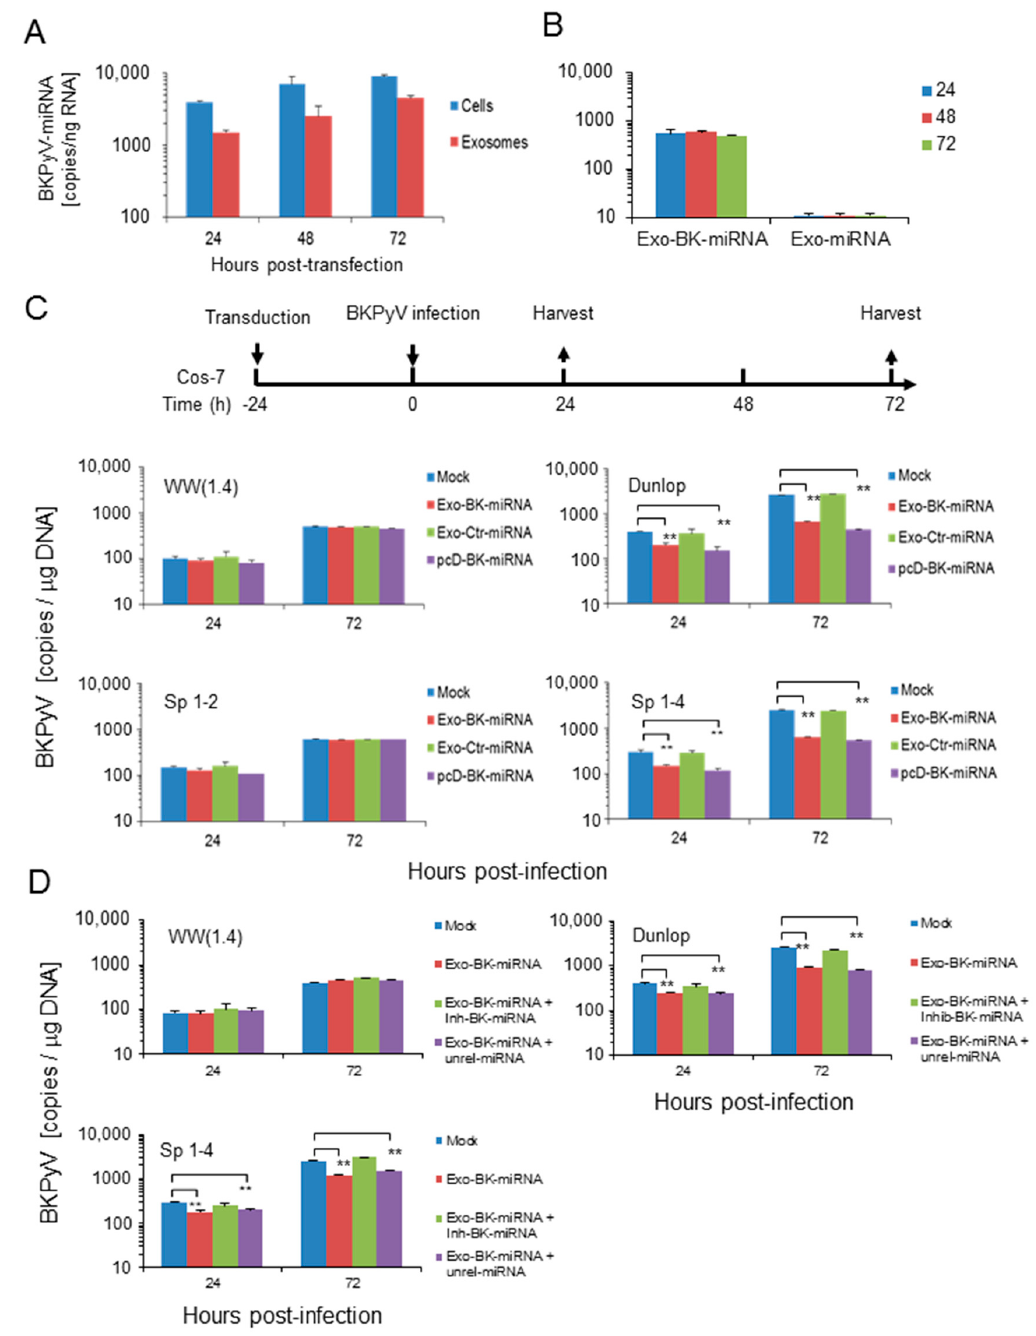
Figure 6. Addition of BKPyV -exosome preparations containing BKPyV -miRNA-5p before infection inhibits replication of BKPyV variants with activated EVGR expression (Dunlop and sp1-4 mutant) but